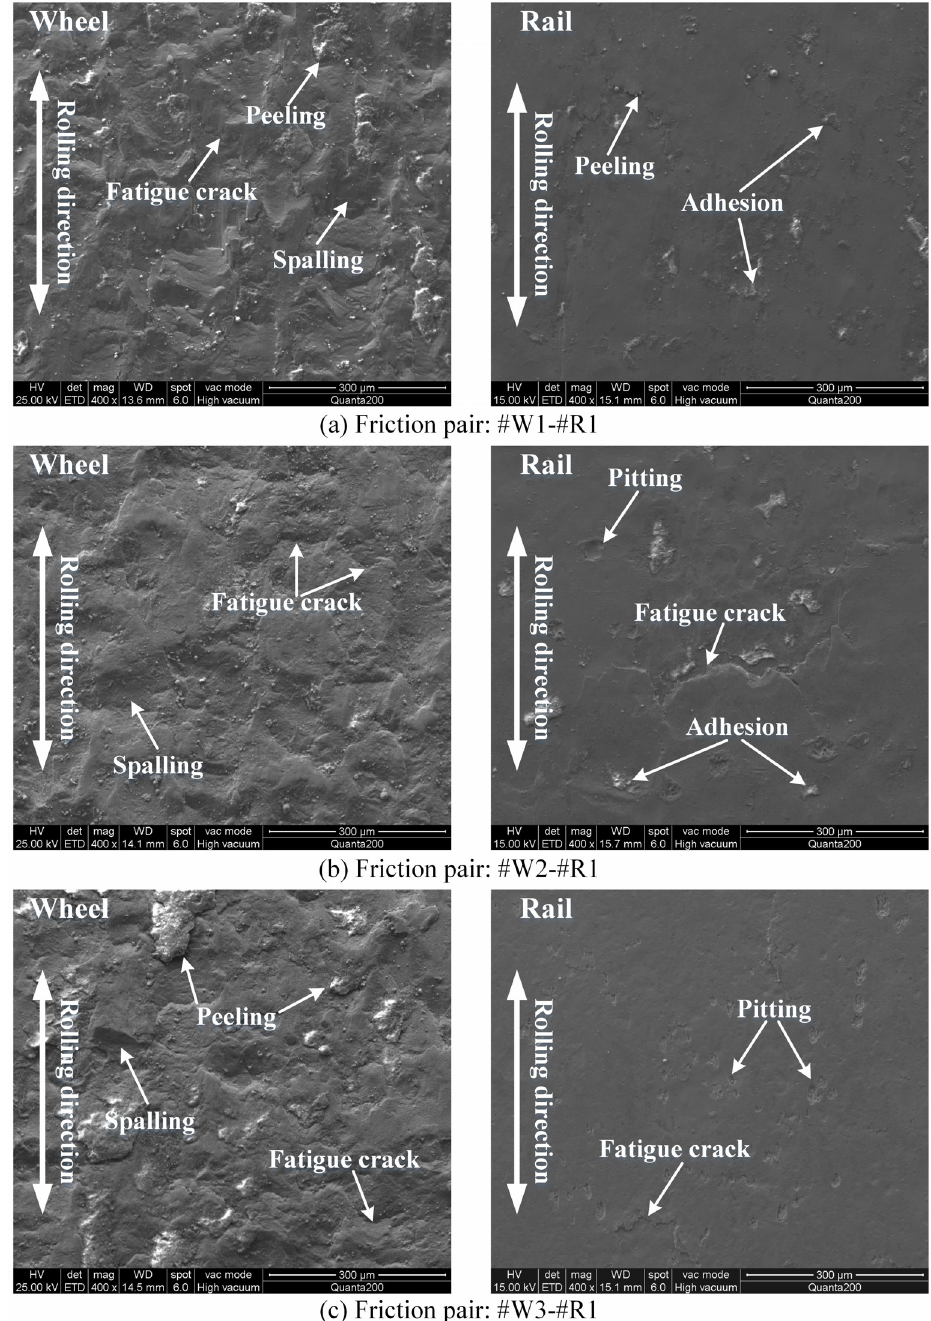
Figure 11. SEM micrographs of surface damage of the wheel / rail discs under di ff erent friction pairs: ( a ) #W1-#R1; ( b ) #W2-#R1; ( c ) #W3-#R1. The SEM micrographs of surface damage of wheel / rail discs under friction pairs #W1-#R2, #W2-#R2 and #W3-#R2 are presented in Figure 12. Figure 13 shows the SEM micrographs of surface damage of wheel / rail discs under friction pairs #W1-#R3, #W2-#R3 and #W3-#R3. Similarly, it is distinct that there are remarkable di ff erences on the surface damage morphology between the wheel and rail discs. that in Figure 11. After the rolling-sliding contact with the wheel discs machined with the same turning parameters, compared with #R1 and #R2, more pitting occurs on the surface of #R3, which indicates that the surface hardness of the rail discs after grinding directly a ff ect the surface wear